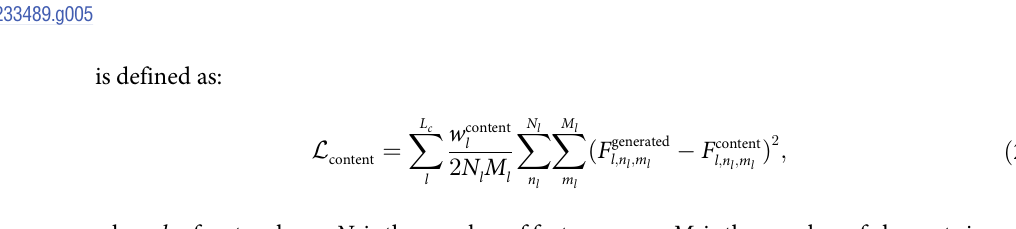
Fig 5. The process flow of the NST. Gram matrices are calculated from style feature maps captured by inputting style and generated images. The difference between the Gram matrices becomes style loss. Also, the difference between content features is content loss. Style and content loss are accumulated into the total loss. Using this total loss the generated image is optimized via